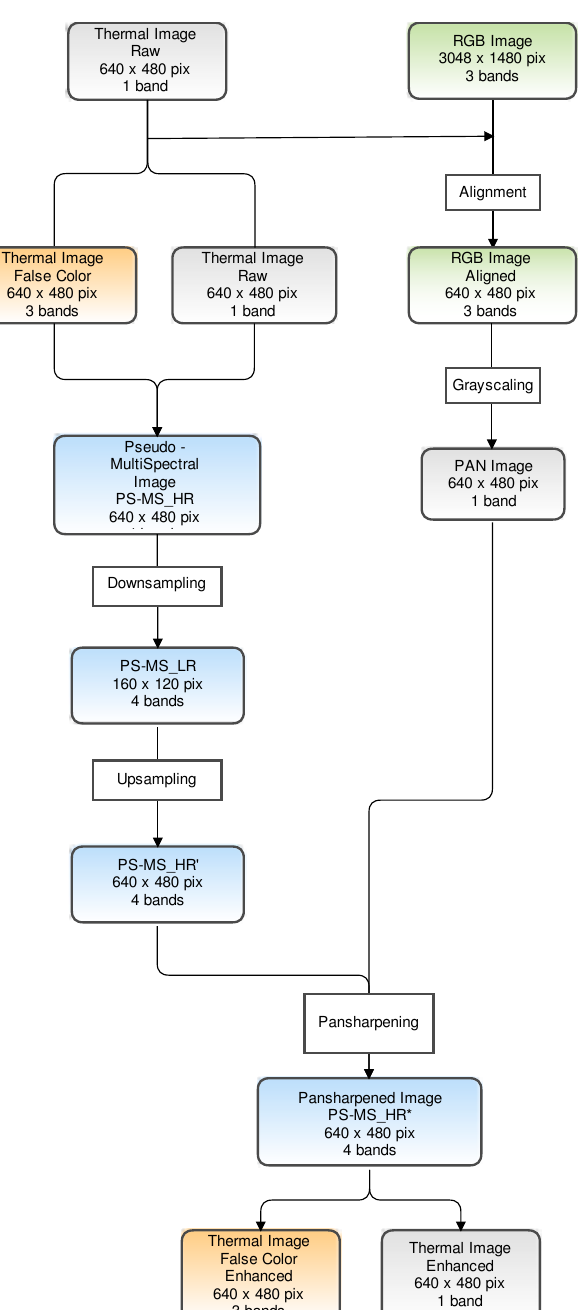
Figure 1. Proposed workflow for the pansharpening assessment methodology of thermal and RGB images with pseudo-multispectral image composition, and the down- and upsampling resolution